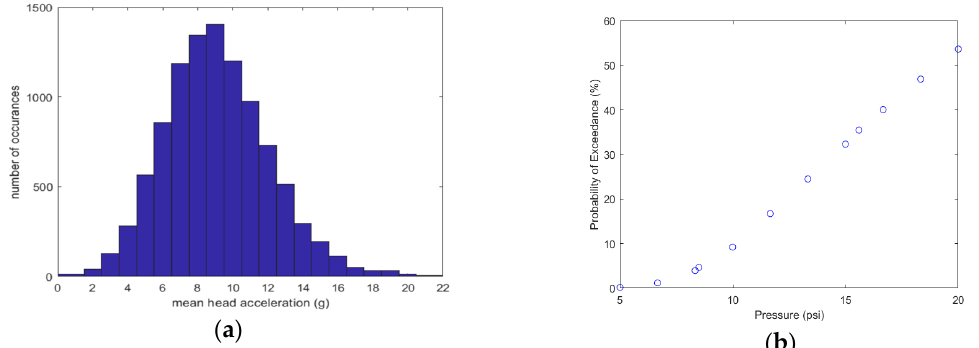
Figure 4. A histogram ( a ) showing the distribution of peak head accelerations through a Monte Carlo simulation with random variables for ball speed, head mass, and neck stiffness for youth. Also from the Monte Carlo simulation, is the probability ( b ) that a certain mean head acceleration exceeds (10